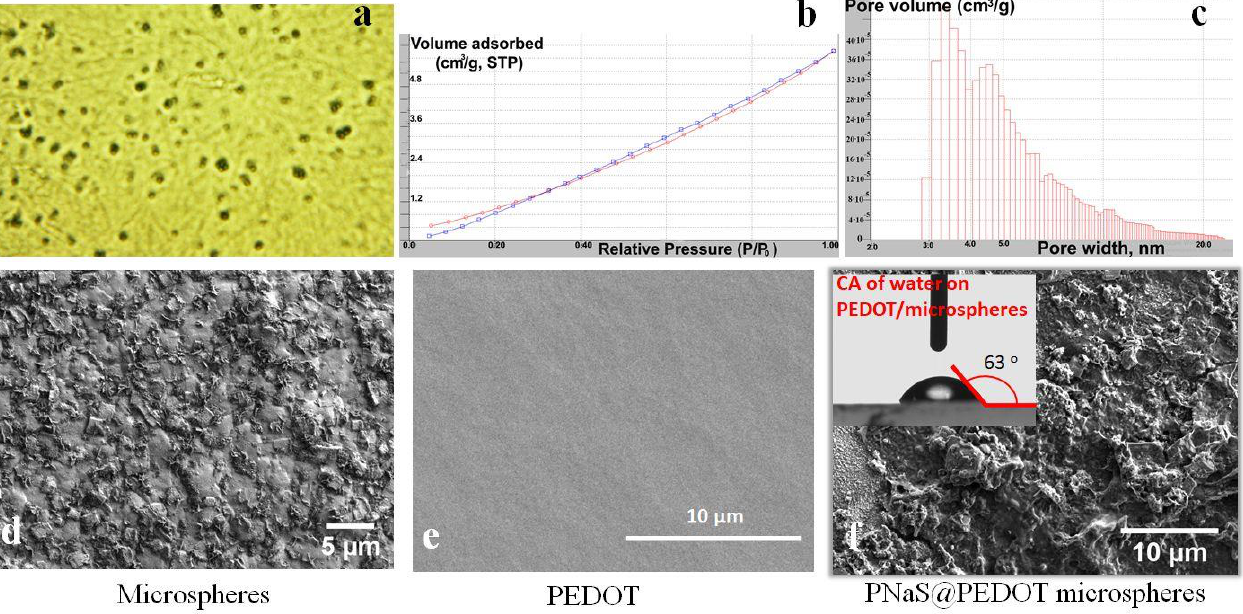
Figure 3. ( a ) Optical microscopy of PNaSS microspheres, ( b ) nitrogen adsorption – desorption iso- therms of PNaSS microspheres, and ( c ) pore size distribution of PNaSS microspheres. ( d ) Scanning electron microscopy images of microspheres, ( e ) PEDOT, and ( f ) PNaSS@ PEDOT microspheres film, and water contact angle (CA) of PNaSS@ PEDOT microspheres.